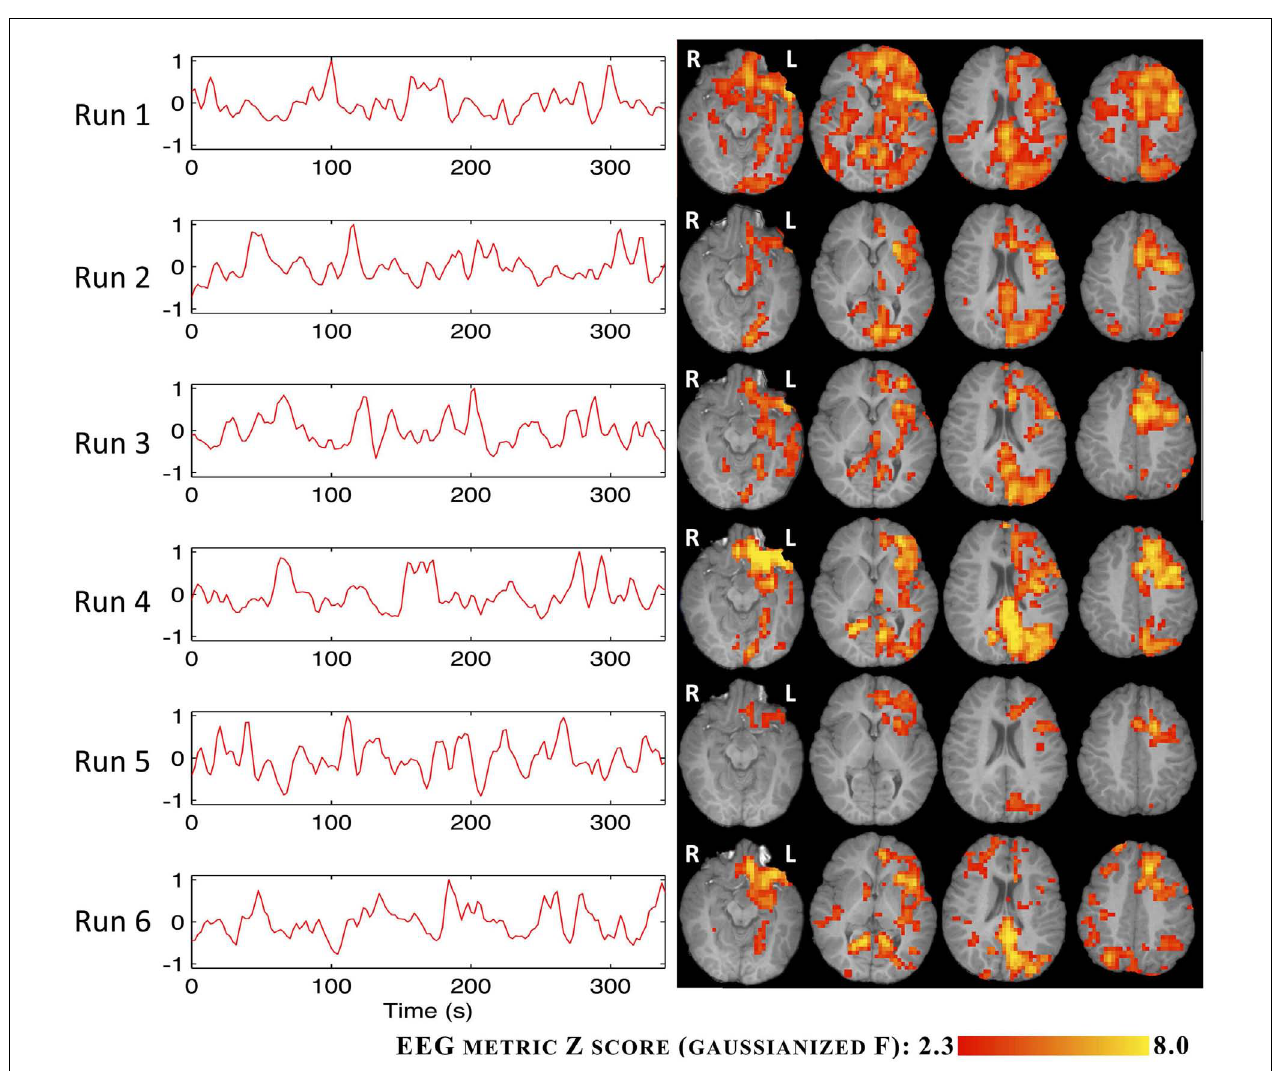
FIGURE 6 |Time courses (left) and Z statistic maps (right) of the RMSF metric for IC group